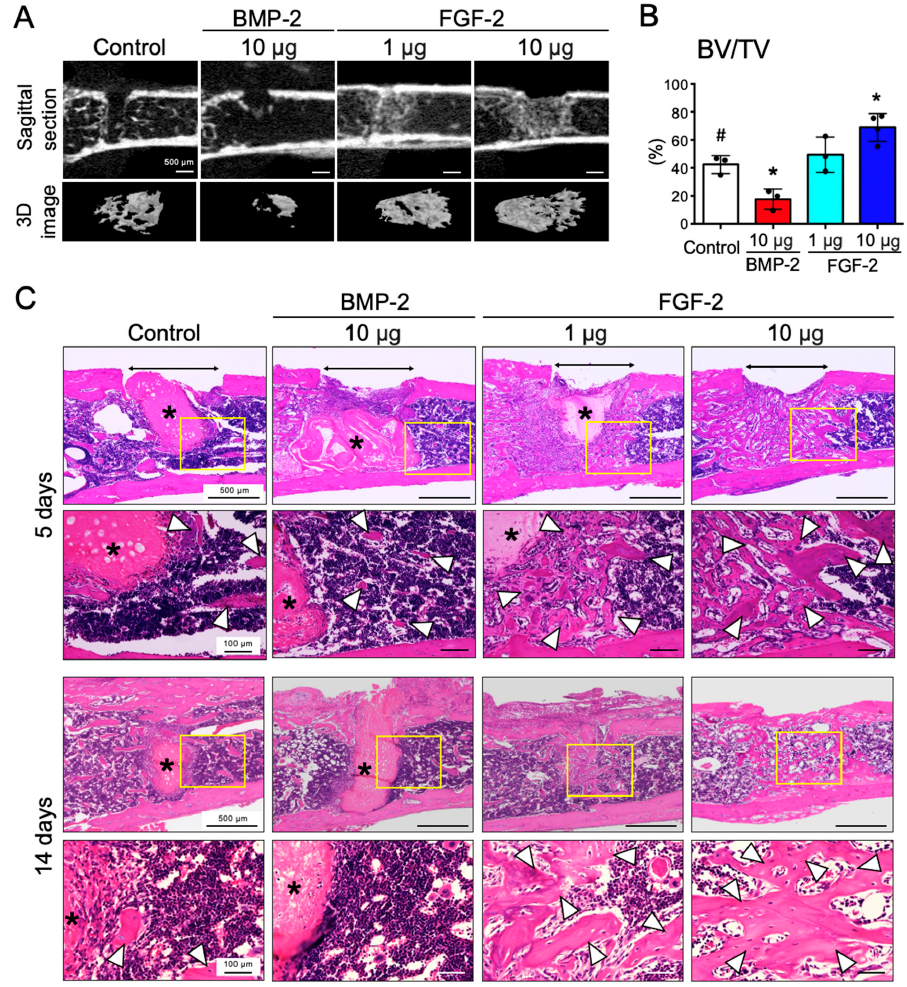
Figure 2. FGF-2, but not BMP-2, promotes repair of mouse femoral defect. Collagen pellets containing BMP-2 (10 µ g) or FGF-2 (1 µ g, 10 µ g) or DW (control) were transplanted into mouse femur